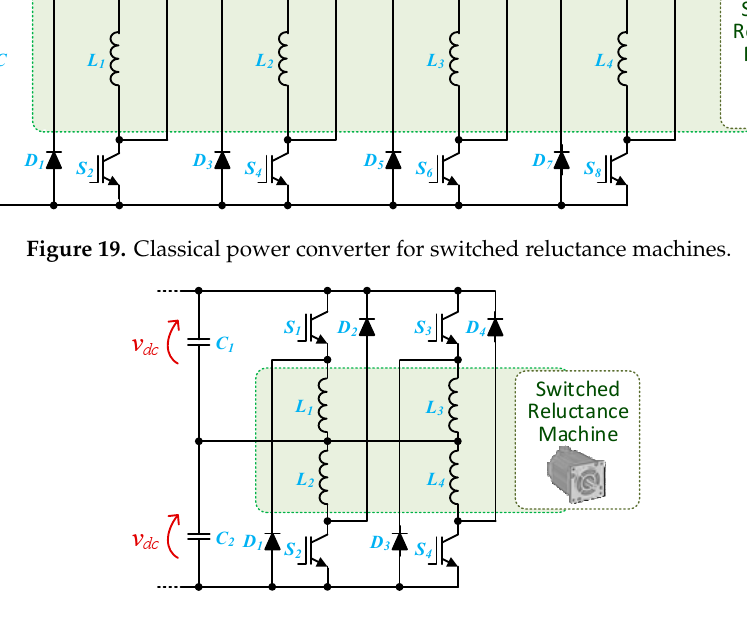
Figure 21. Miller power converter for switched reluctance machines. As previously referred to, current source converters use an inductor in the dc link instead of a capacitor for storing energy, making the converter operating as a current source. In Figure 22 is shown a three-phase current source converter. The main advantages of this type of power converters, when used in EVs, are: (i) inherent short-circuit protection; (ii) the produced ac currents have lower high-frequency ripple; (iii) it is not necessary to connect antiparallel diodes to the fully-controlled switching devices; (iv) it is possible to obtain higher output ac voltages than the input dc voltage. However, this type of power converter also presents disadvantages compared to voltage source converters: higher volume and weight; higher risk of over-voltages and voltage spikes, as well as the necessity of using switching devices capable of blocking bipolar voltages—the reverse-blocking insulated gate bipolar transistor (RB-IGBT) is an example of such power semiconductor, which has the disadvantage of having higher conduction and switching losses than regular IGBTs, besides being more expensive. Alternatively to the use of RB-IGBTs, a diode can be placed in series with each IGBT, which also increases the overall losses and cost of the power converter [212,216,217].